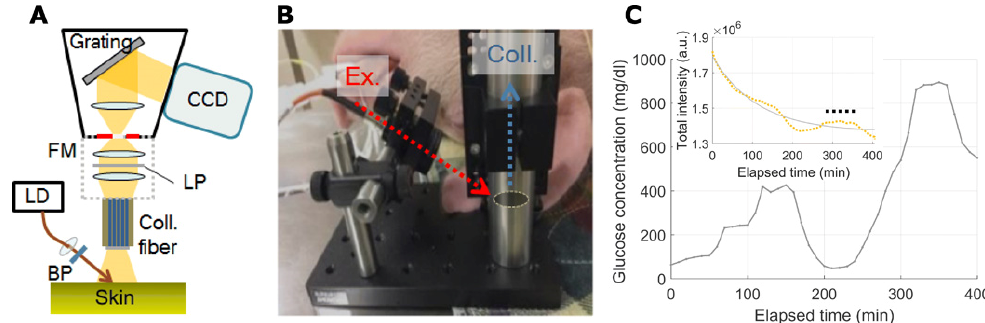
Figure 9. The suggested system: ( A ) schematic diagram, ( B ) experiment setup, and ( C ) obtained glucose profile. Exponential time decay of fluorescence from the skin in the inset (actual data in the yellow dotted line and its exponential approximation in the gray line). Reprinted with permission from [30].